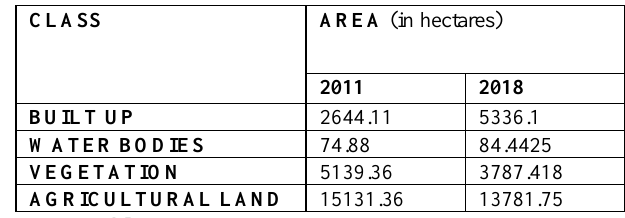
Table 1 . Land use changes between 2011 and 2018. Figure 2 and 3 show the land use and land cover mapped using